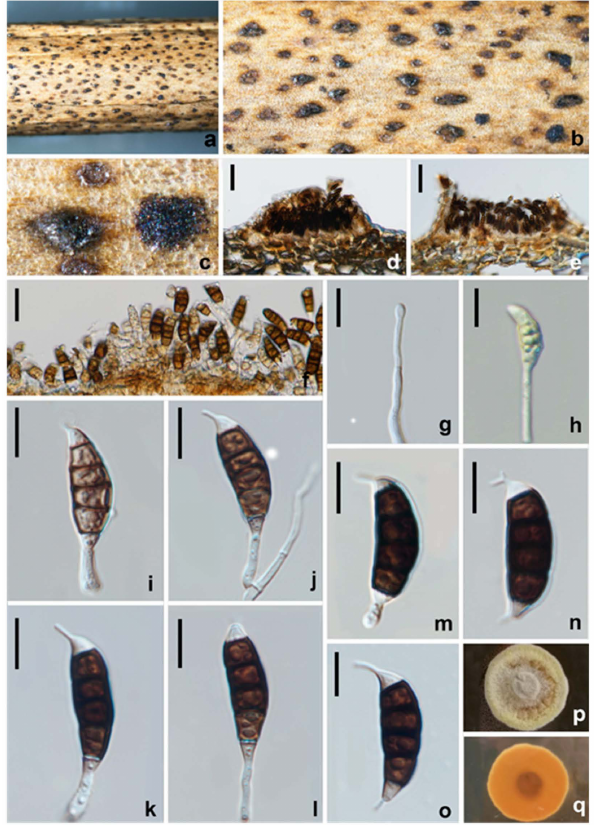
Figure 15. Seiridium rosarum (HKAS 123217). ( a – c ) Appearance of conidiomata on host substrate. ( d , e ) Vertical section of conidiomata. ( f – l ) Conidiogenous cells and conidia. ( m – o ) Conidia. ( p , q ) Upper and reverse view of the colony on PDA. Scale bars: ( d , e ) = 50 µ m, ( f ) = 20 µ m, ( g – o ) = 10 µ m. Culture characteristics: Colonies on PDA reaching 20 mm diam. after 2 weeks at 25 ◦ C. Cultures from above are paler-yellowish, dense, circular, umbonate, papillate with fluffy, covered with white aerial mycelium; reverse orange, paler-yellowish at the